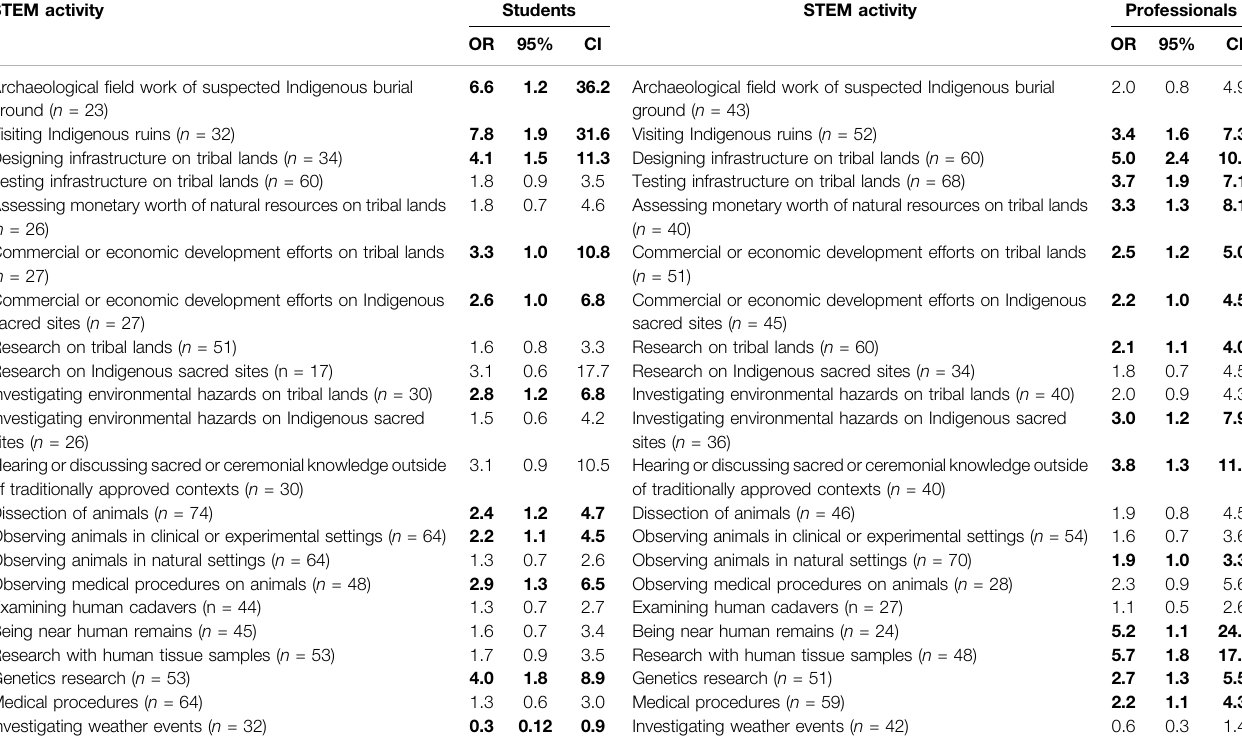
TABLE 3 | Association between cultural characteristics and perspectives on ethical concern for STEM activities among STEM students and professionals. STEM